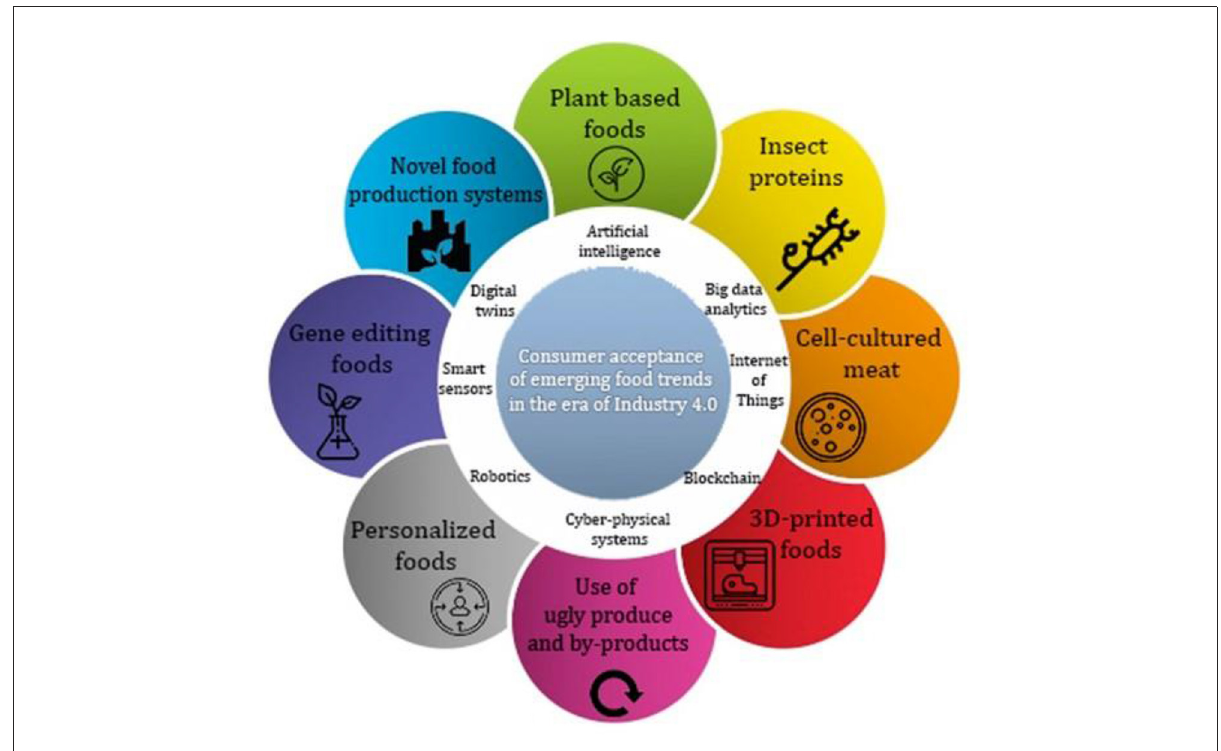
FIGURE1 The food trends reviewed in this manuscript and the main enablers of the fourth industrial